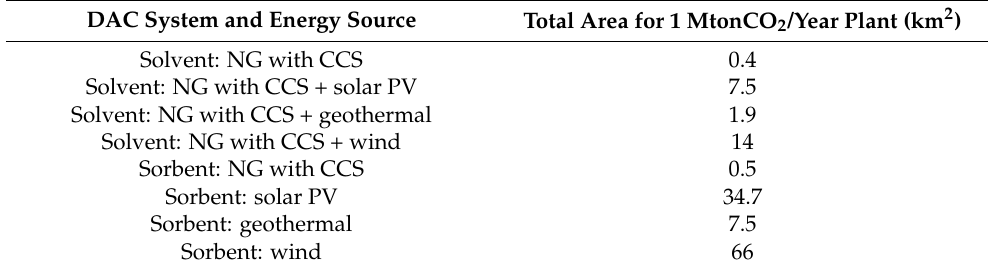
Table 7. Land use for different combinations of DAC systems and energy sources. NG: natural gas, PV: photovoltaic, CCS: carbon capture and storage